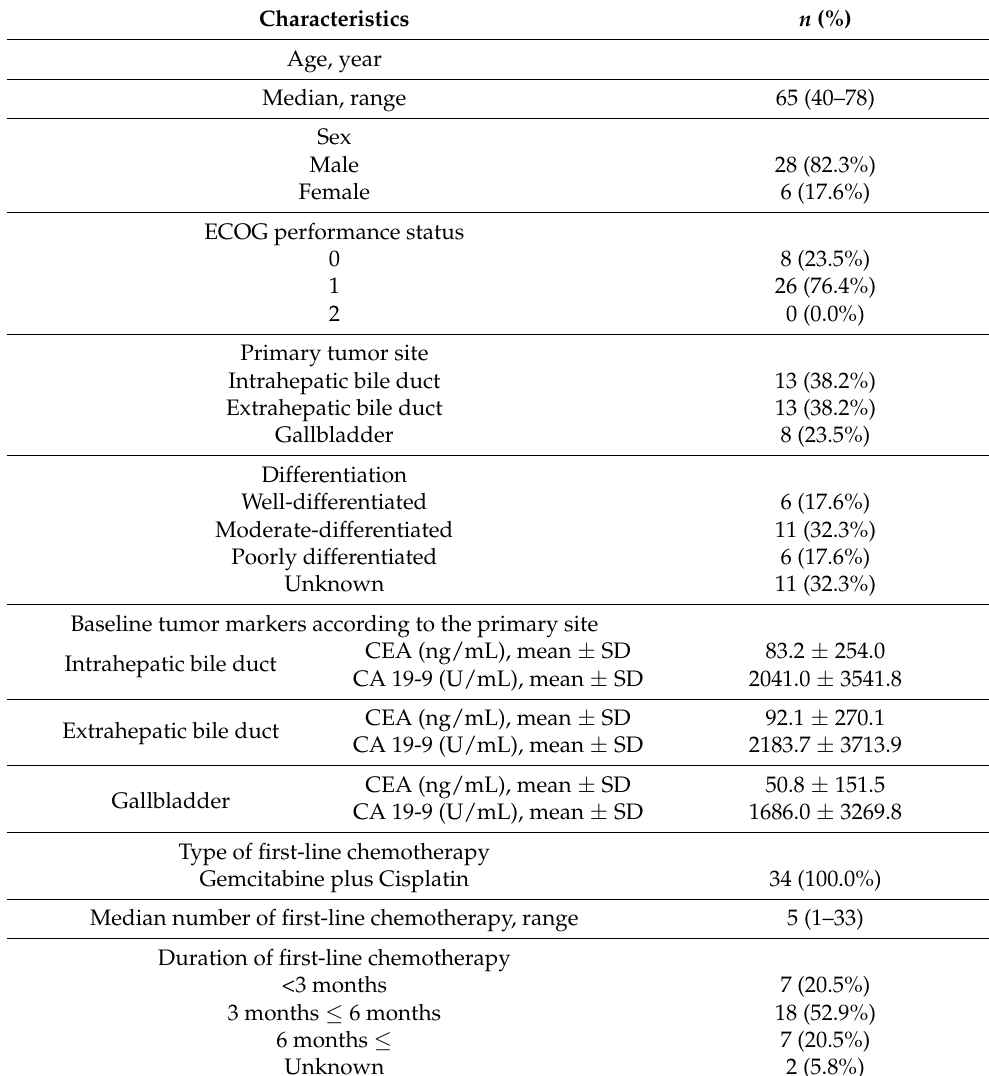
Table 1. Baseline demographics and disease characteristics at the time of enrollment ( n =